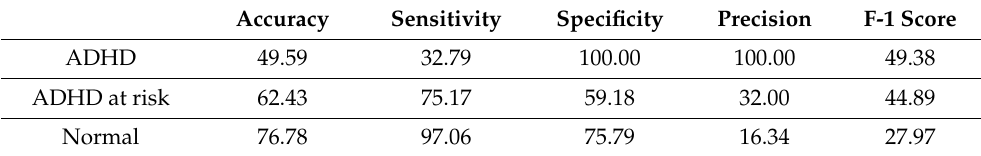
Table 11. The performance of existing screening diagnostic tools (%). Accuracy Sensitivity Specificity Precision ADHD